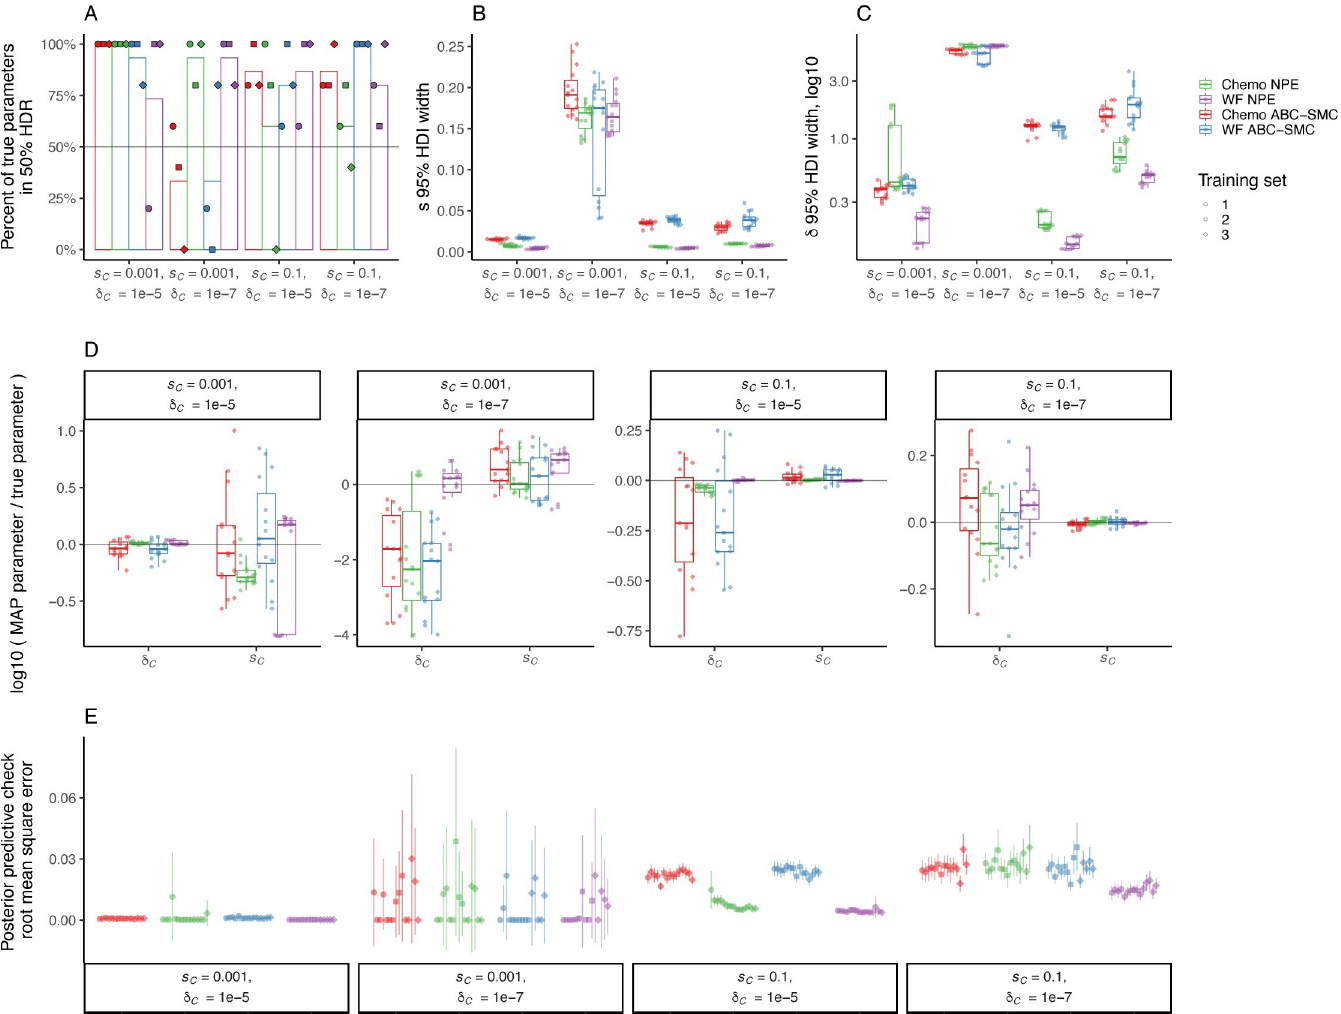
Fig 3. Performance assessment of inference methods using simulated synthetic observations. The figure shows the results of inference on 5 simulated synthetic and formation rate δ C . Simulations and inference were performed observations using either the WF or chemostat (Chemo) model per combination of fitness effect s C using the same model. For NPE, each training set corresponds to an independently amortized posterior distribution trained on a different set of 100,000 simulations, with which each synthetic observation was evaluated to produce a separate posterior distribution. For ABC-SMC, each training set corresponds to independent inference procedures on each observation with a maximum of 10,000 total simulations accepted for each inference procedure and a stopping criteria of 10 iterations or ε < = 0.002, whichever occurs first. (A) The percent of true parameters covered by the 50% HDR of the inferred posterior distribution. The bar height shows the average of 3 training sets. Horizontal line marks 50%. (B, C) Distribution of widths of 95% HDI of the posterior distribution of the fitness effect s (B) and CNV formation rate δ C (C), C calculated as the difference between the 97.5 percentile and 2.5 percentile, for each separately inferred posterior distribution. (D) Log ratio of MAP estimate to true parameter for s and δ C . Note the different y-axis ranges. Gray horizontal line represents a log ratio of zero, indicating an accurate MAP estimate. (E) Mean and 95% C confidence interval of RMSE of 50 posterior predictions compared to the synthetic observation from which the posterior was inferred. Data and code required to generate this figure can be found at https://doi.org/10.17605/OSF.IO/E9D5X. ABC-SMC, Approximate Bayesian Computation with Sequential Monte Carlo; CNV, copy number variant; HDI, highest density interval; HDR, highest density region; MAP, maximum a posteriori; NPE, Neural Posterior Estimation; RMSE, root mean square error; WF,